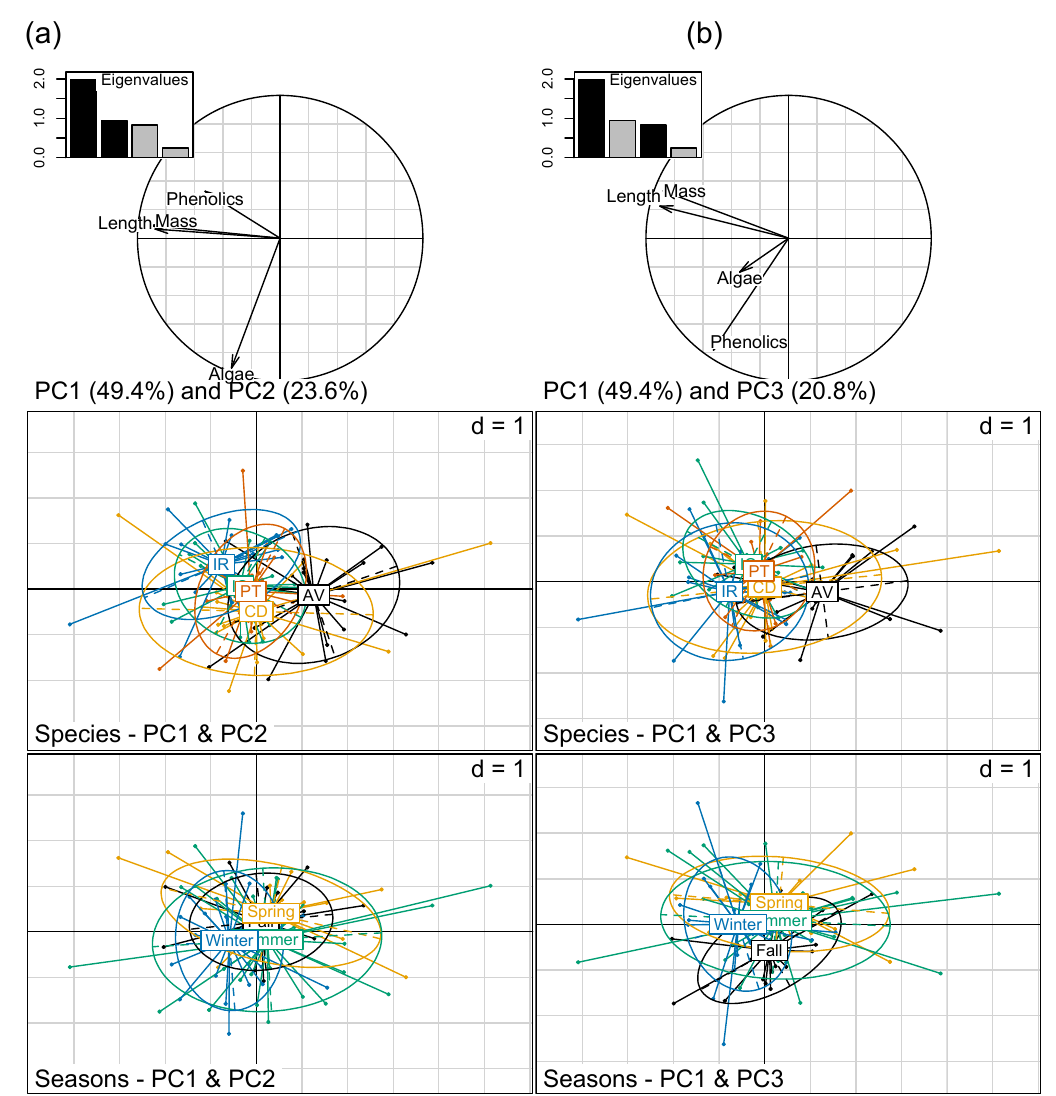
Figure 3. Results of Principal Components Analysis following Phase 1 of the mesocosm experiment. In ( a ) Principal Component (PC) 1 is negatively correlated with eelgrass length and mass and PC 2 is negatively correlated with epiphytic algal mass. In ( b ) PC 3 is negatively correlated with phenolic concentration. The lower plots show the data color coded by species (abbreviations as in Figure 1) or seasons. Ellipses grouping the data encompass ~67% of the